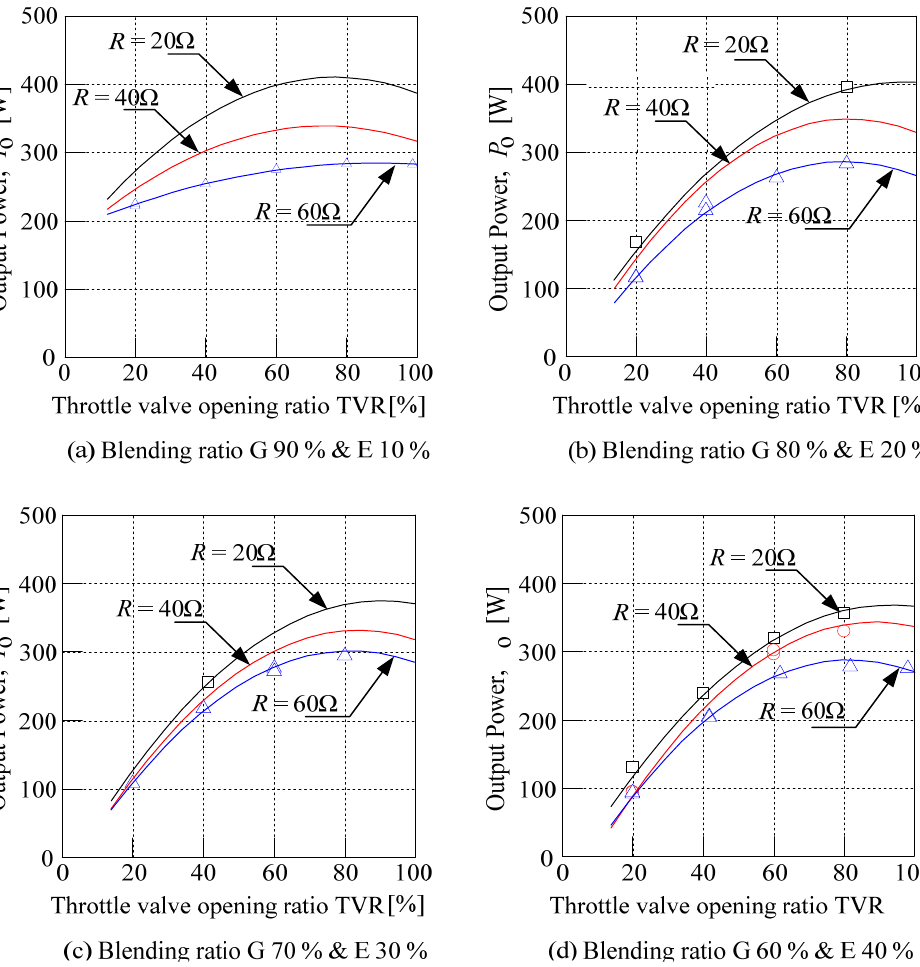
Figure 7. Effect of throttle valve ratio (TVR) on the generator output power. ( a ) Blending ratio G 90% & E 10%; ( b ) Blending ratio G 80% & E 20%; ( c ) Blending ratio G 70% & E 30%; ( d ) Blending ratio G 60% & E